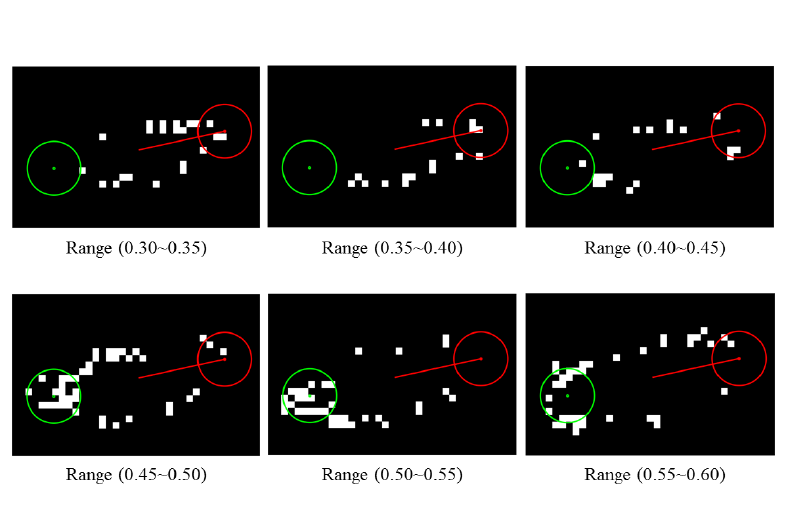
Figure 7. Filtered image at different threshold range levels. Two search points illustrated as red and green are located at the end of the major axis. A number of threshold ranges are applied to a blob resulting in white pixels. Each search point collects a score by counting a number of white pixels located within its range. The higher the number of white pixels that a search point found, the higher the probability of that point to contain wings. In this figure, wings of the fly are likely to be located at the green